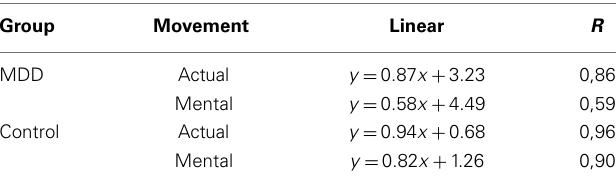
Table 2 | Linear regression equations calculated between the index of difficulty and the average actual or mental movement durations for both groups